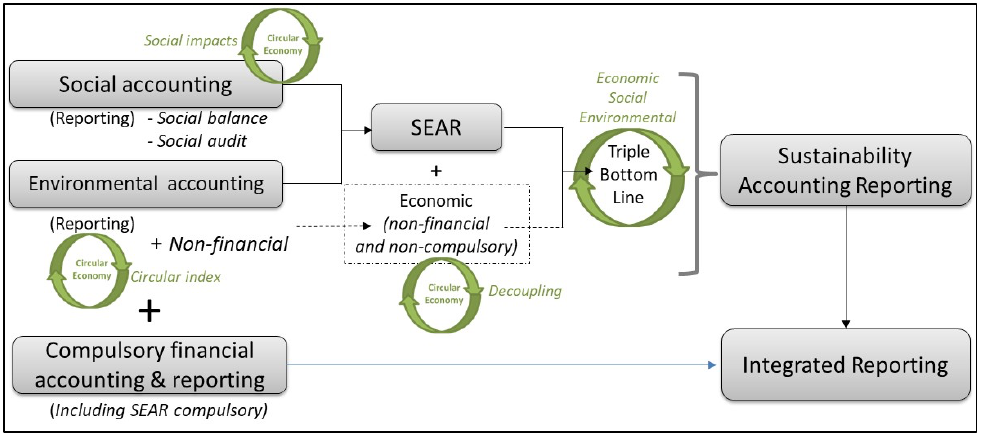
Figure 2. Circular sustainability accounting framework of